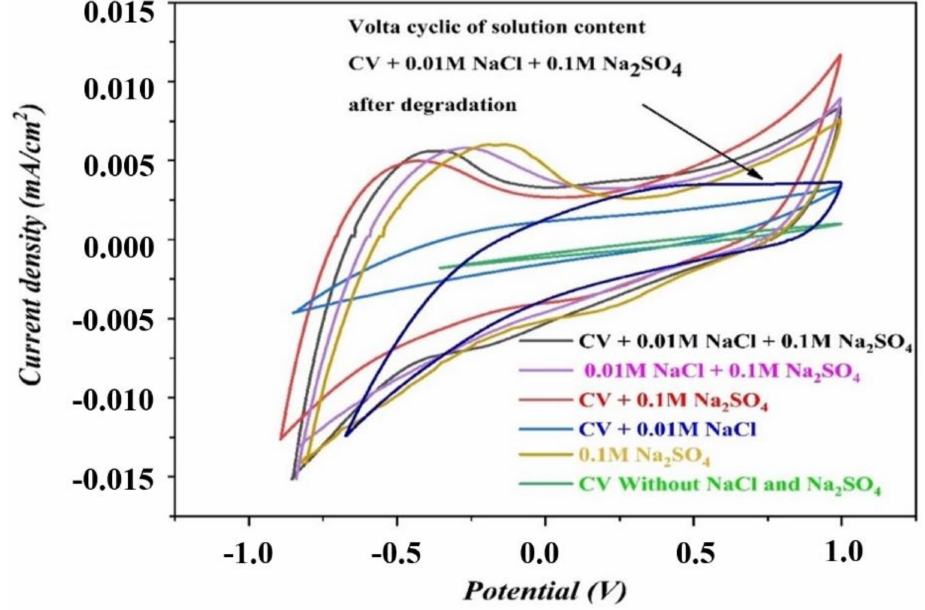
Figure 3. Cyclic voltammetry curve on an Ti/Pt/SnO 2 electrode, with a scan rate of 1 V s − 1